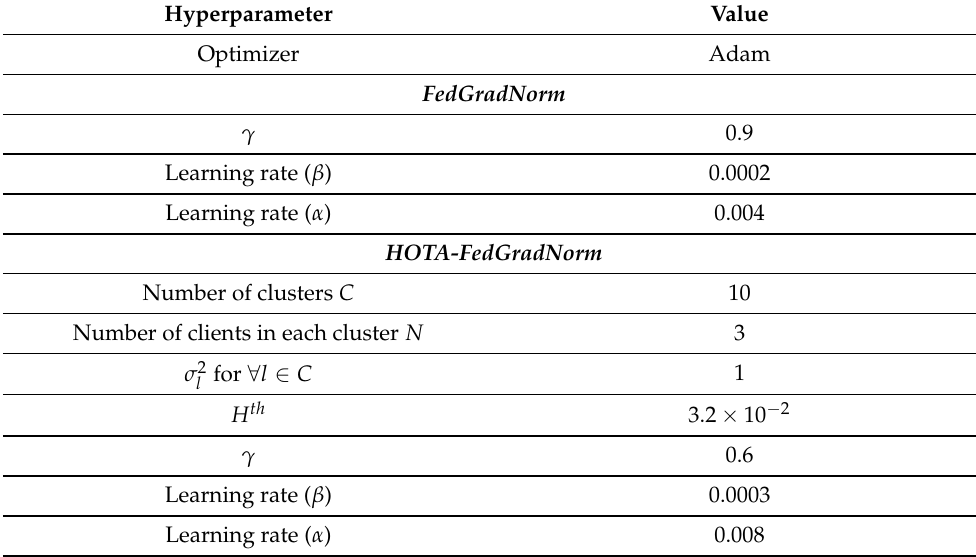
Table 2. System model hyperparemeters.